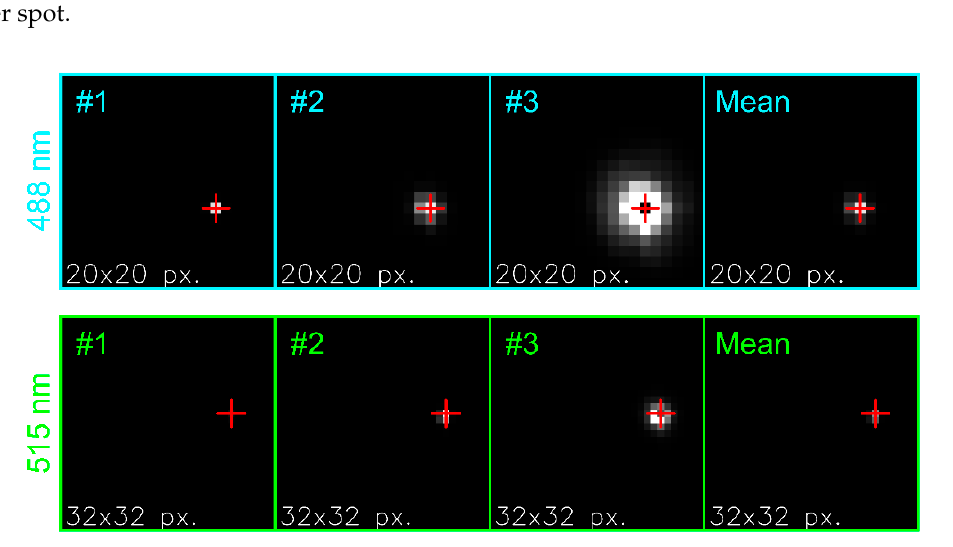
Figure 8. Estimation of the laser spot center for the camera lens Edmund Optics 86410 ( 𝐹 = 2.8 ). Top row: 𝜆 = 488 nm , bottom row: 𝜆 = 515 nm . From left to right: Sections of camera images acquired with setting no. 1–3 of Table 4 and the corresponding mean image. A red cross marks the center of the laser spot (estimated from the mean image). The red crosses in the images #1–#3 are derived from the mean image.